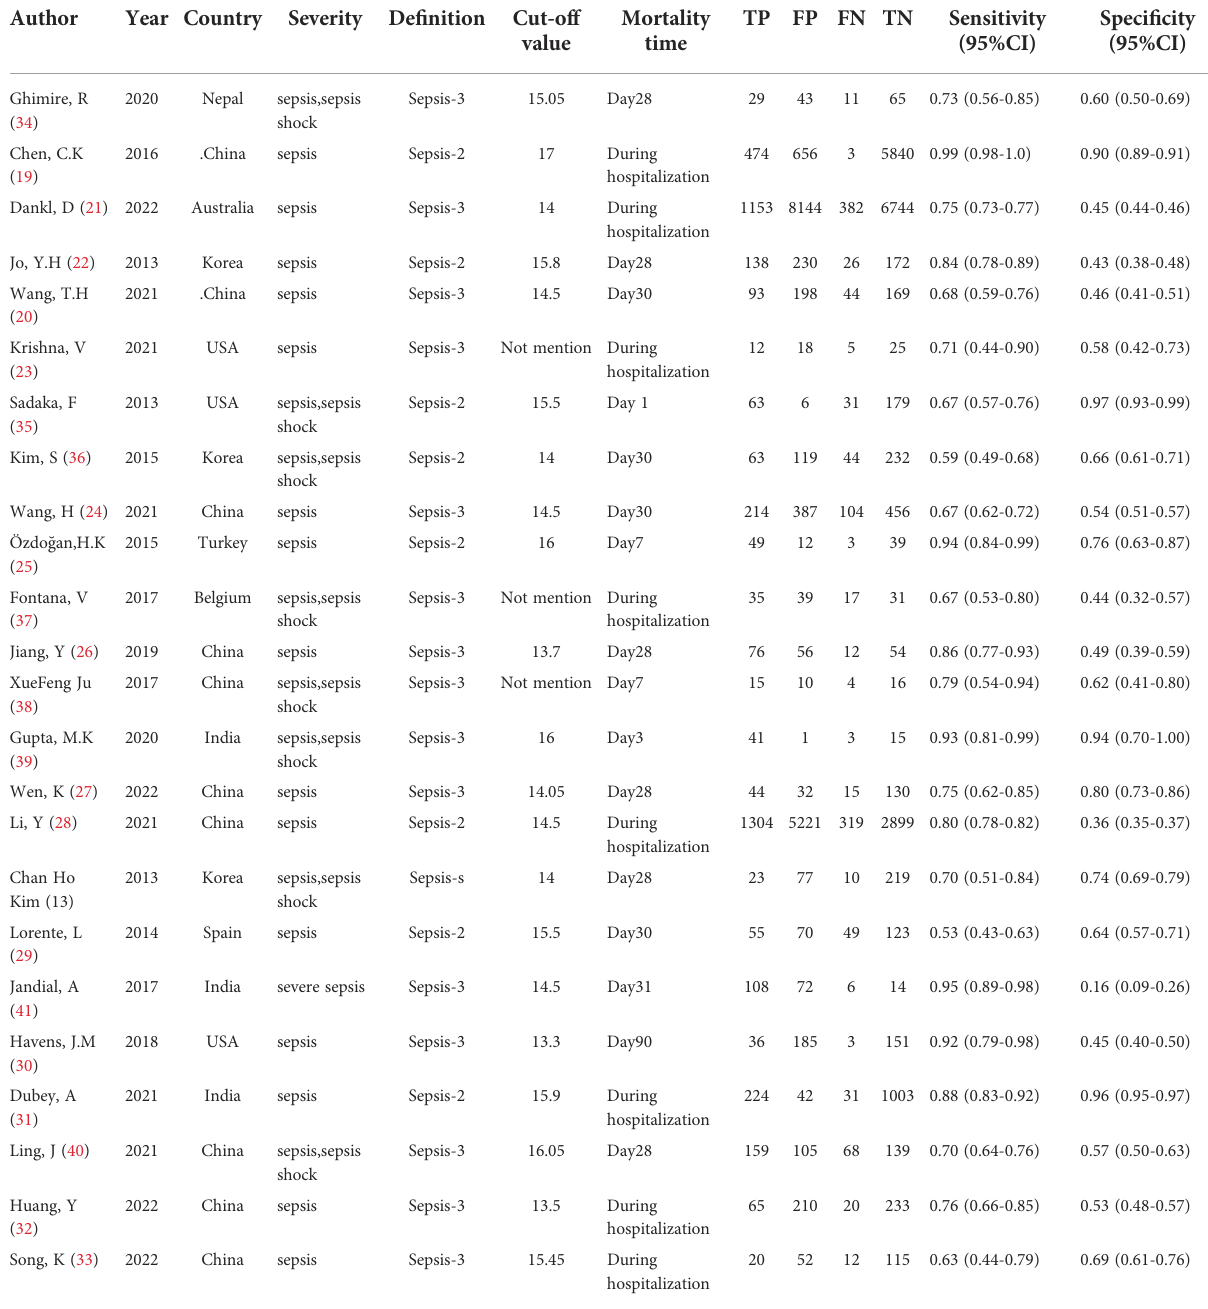
TABLE 1 Characteristics of the including